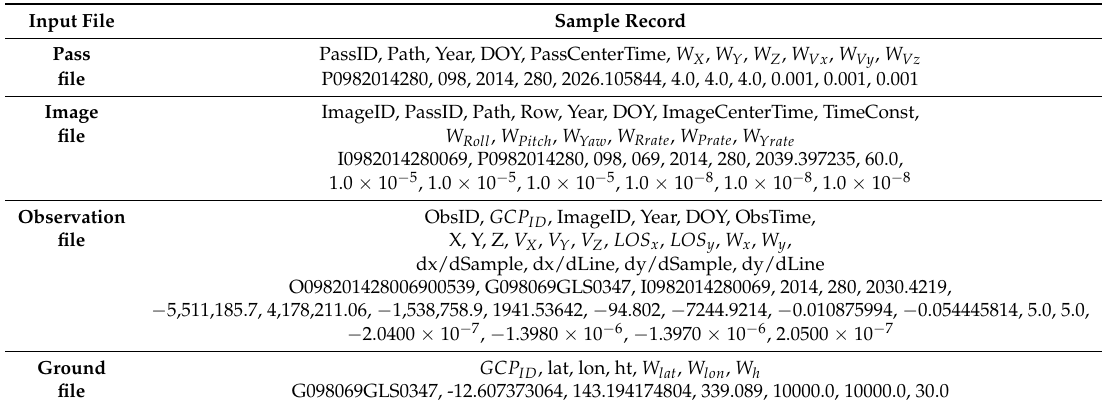
Table 3. A sample record for the four input files used in the triangulation method. The input files contain a priori information and are linked with each other by a unique identifier. The description for the comma-separated values is provided at the top for each of the